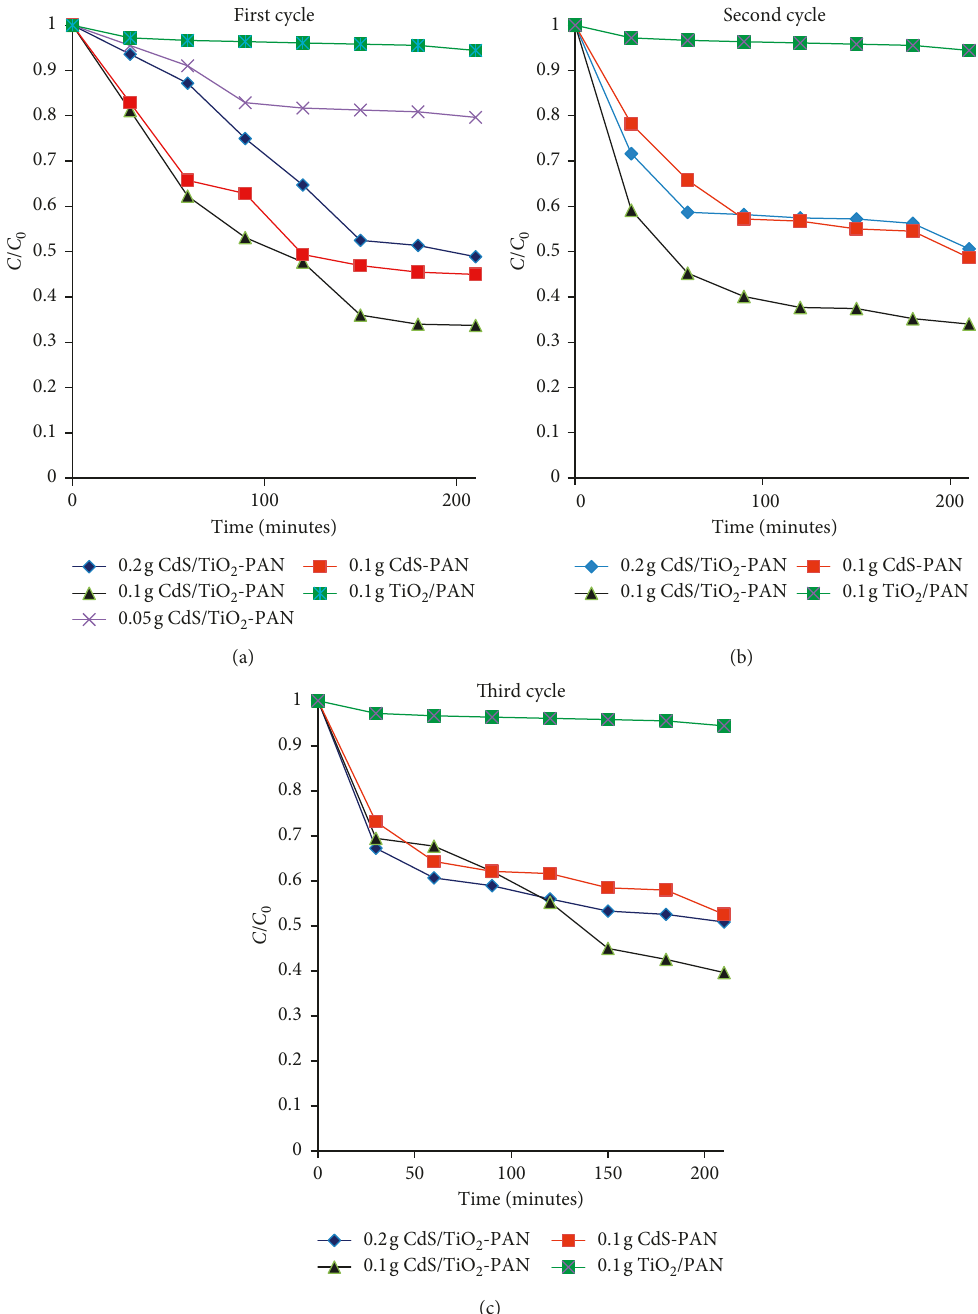
Figure 8: Photodegradation profiles of 150 mL of 10ppm methylene blue using photocatalytic membranes with different catalyst loadings under visible light at 25 ° C and pH